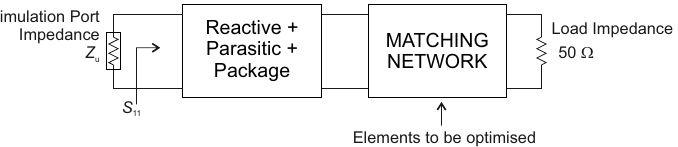
Figure 3. Typical simulation setup used for designing matching networks in a linear